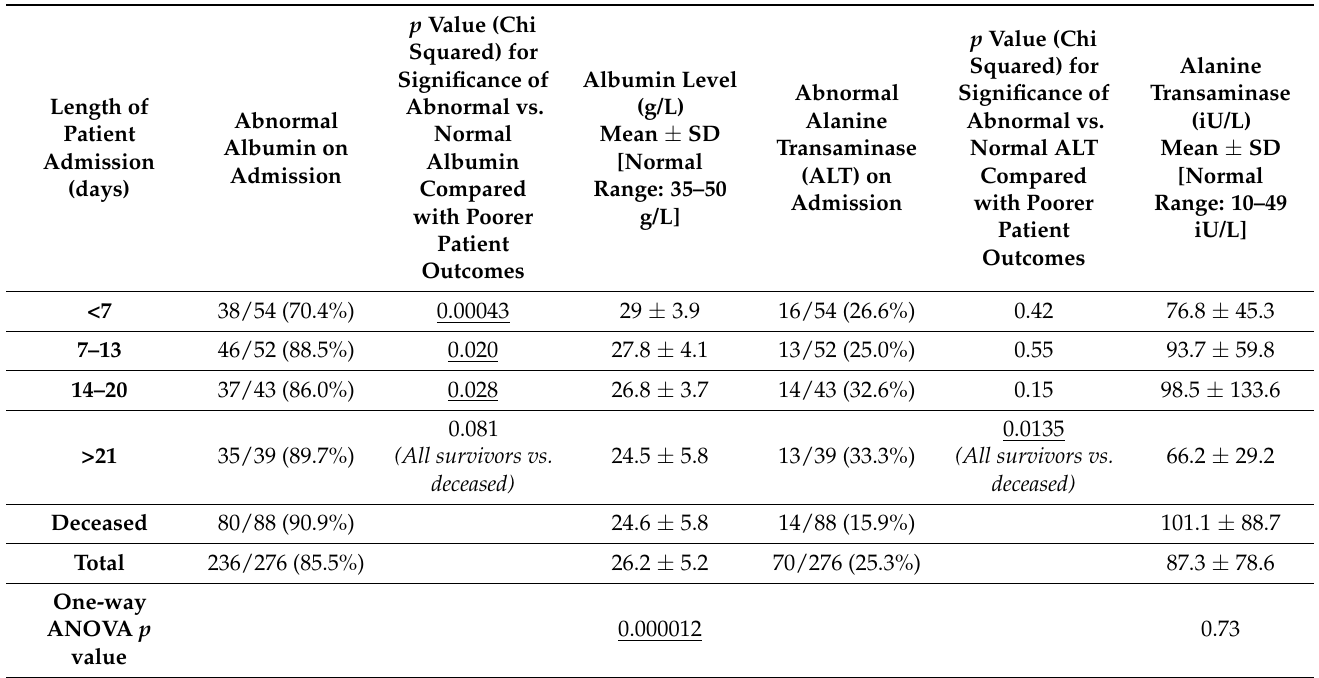
Table 5. Results of analysis of two post-mortem liver function tests, albumin and alanine aminotransferase (ALT), as a function of length of hospital admission and patient survival data. Statistically significant results below the 0.05 level are